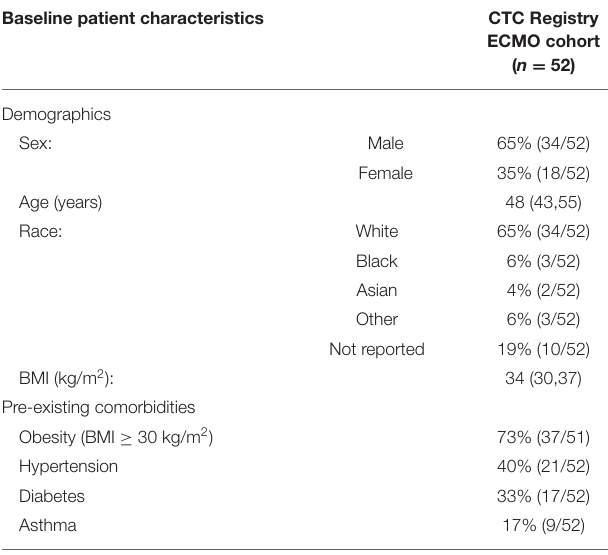
TABLE 1 | Baseline characteristics of the CTC Registry ECMO